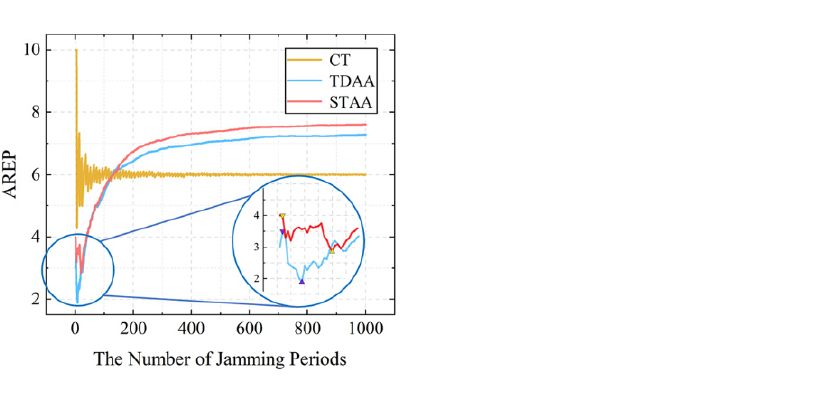
Figure 7. Schematic diagram comparing the DFR between the TDAA [11] and the STAA.